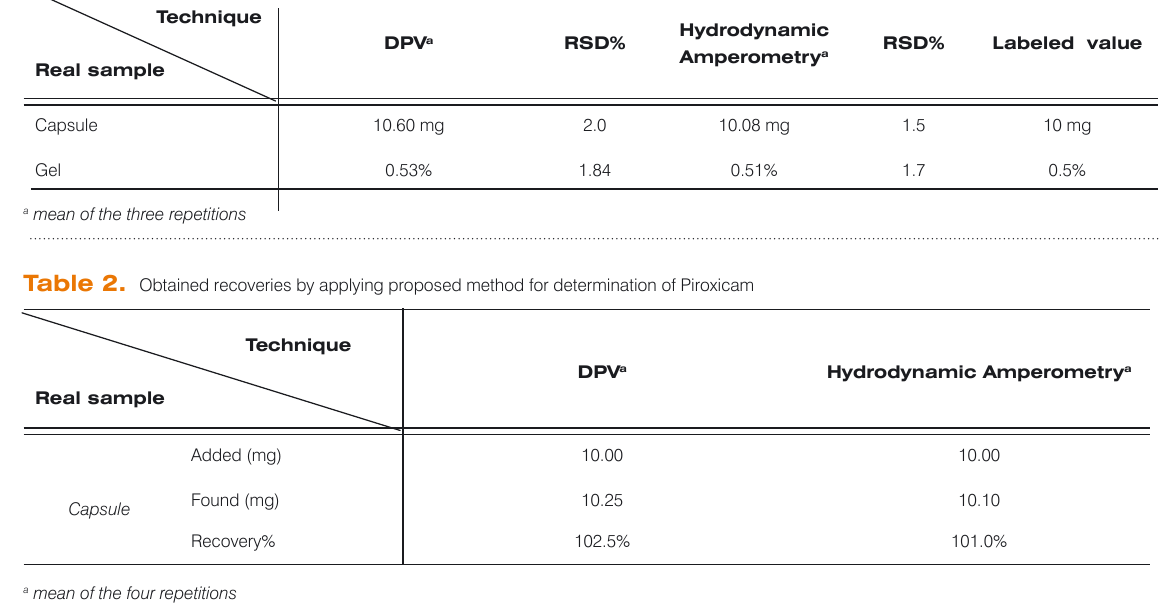
in Table 1 . The results obtained from the proposed procedures were compared with labeled amounts.